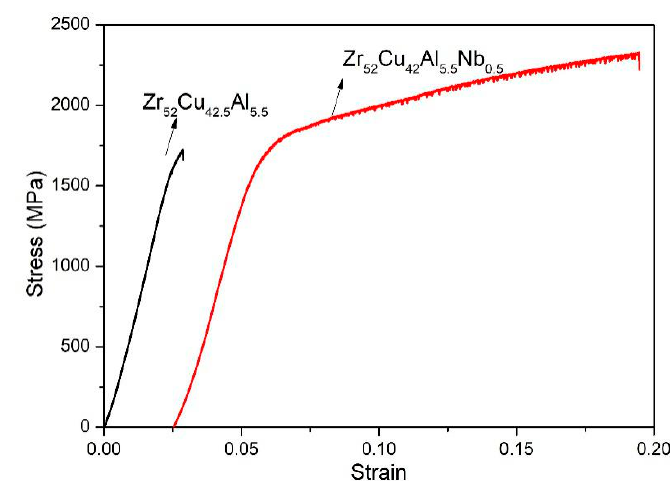
Figure 2. Compressive loading strain–stress curves of Zr 52 Cu 42.5 ‐ x Al 5.5 Nb x (x = 0 and 0.5 atom%) specimens. The fracture and lateral surfaces of Zr 52 Cu 42.5-x Al 5.5 Nb x (x = 0 and 0.5 atom%) are presented in